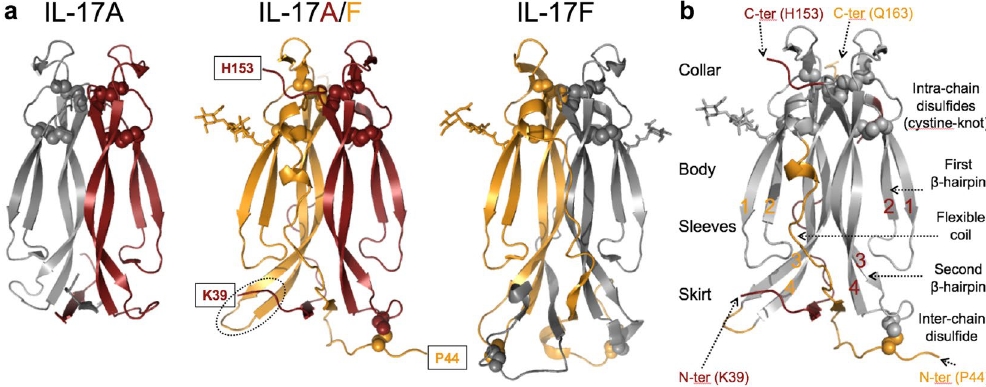
Figure 1. Structure of human IL-17A/F. ( a ) Ribbon diagram of IL-17A/F (center view; A chain, carmine; F chain, orange) and comparison with IL-17A (left, 4hr9.pdb) and IL-17F (right, 1jpy.pdb). Disulfides are represented with spheres. Sugar residues are shown in stick representation. Observed N- and C-termini of IL- 17A/F are boxed. The tip of the second β -hairpin of the F-chain is highlighted with a dotted ellipse. ( b ) Upside down orientation emphasizing the analogy between the IL-17 fold and a garment. Structurally-conserved regions in IL-17A/F with respect to the corresponding homodimers are in grey, while non-conserved structural elements are in carmine (A chain) or orange (F chain). The β -strands forming the two β -hairpins of each subunit are numbered sequentially 1 to